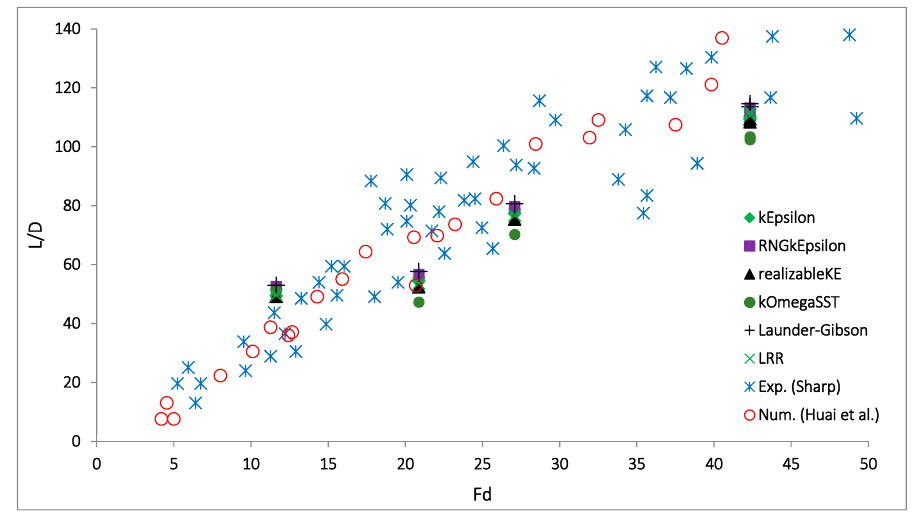
Figure 7. Cling length comparison of numerical vs. experimental results (Source: [23]).